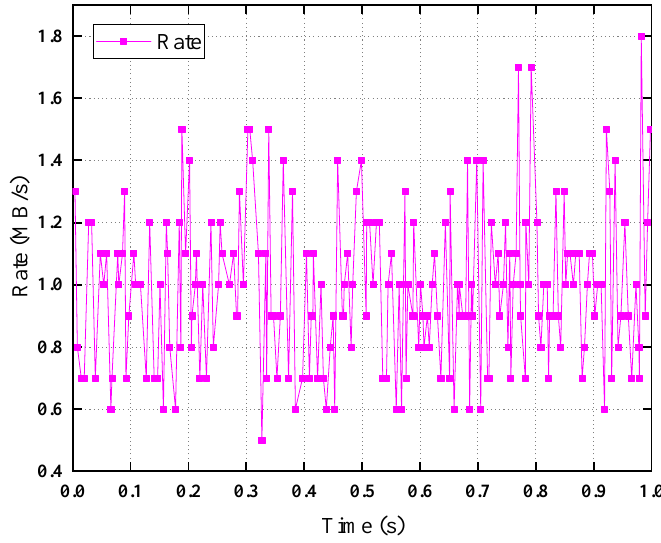
Figure 11. Poisson background traffic model